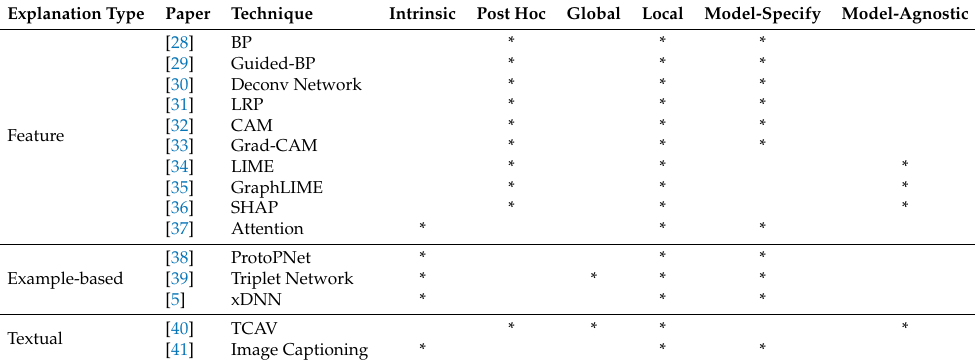
Figure 3. Categorization of explainable AI methods used in this paper. These criteria and categories are summarized from [25–27]. The orange and blue grids represent the criteria and categories, respectively. Table 1. Summary of explainable AI techniques classified according to Section